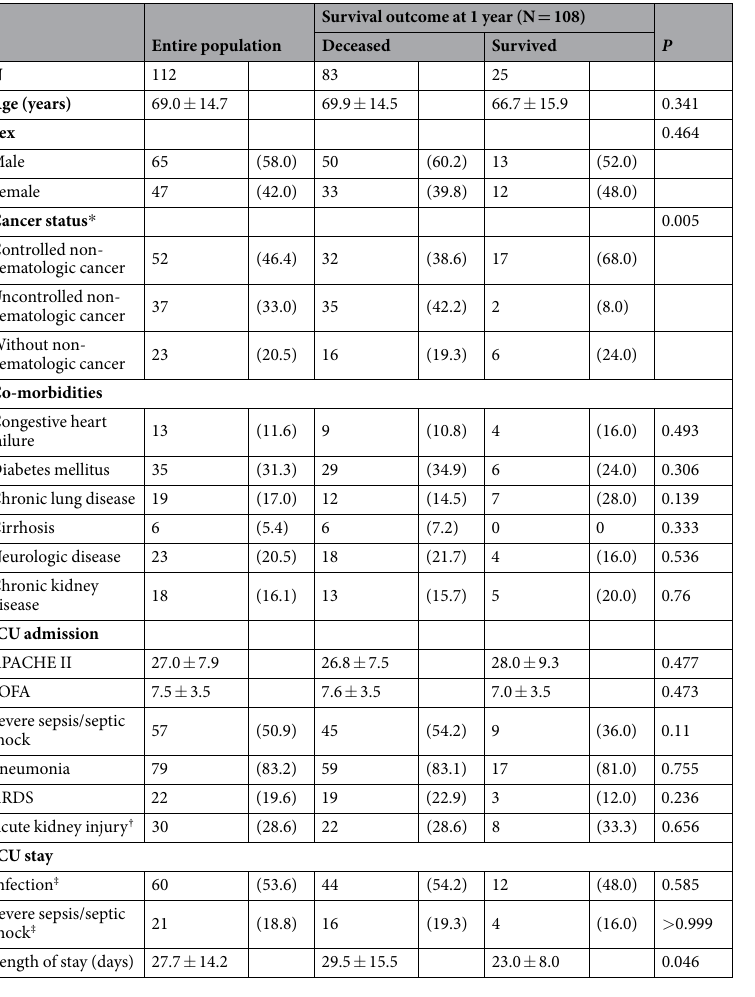
Table 2. Clinical characteristics at baseline and during intensive care unit hospitalization. Data are presented as the mean ± standard deviation or number (%). APACHE II, Acute Physiology and Chronic Health Evaluation score; ARDS, acute respiratory distress syndrome; ICU, intensive care unit; SOFA, Sequential Organ Failure Assessment score. * Disease conditions classified as cure, complete remission, partial remission, or stable disease were considered under control, while those classified as progressive or newly-diagnosed diseases were considered uncontrolled. In patients with non-hematologic malignancies from two different origins, the disease status was defined as uncontrolled if either one was uncontrolled. † In patients without end-stage renal disease before admission. ‡ Hospital-acquired infection and hospital-acquired severe sepsis/septic